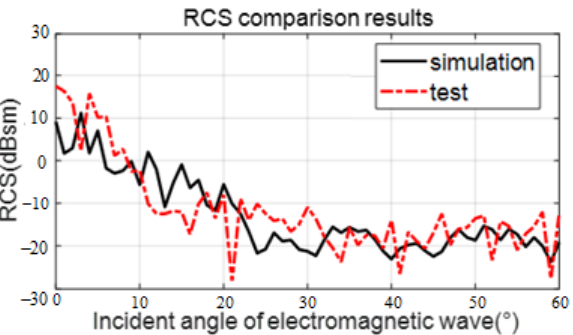
Figure 14. Comparison of scaled sea surface RCS between simulation and test. The solid black line represents the simulation results. The dashed red line represents the actual scaled model measurement results.